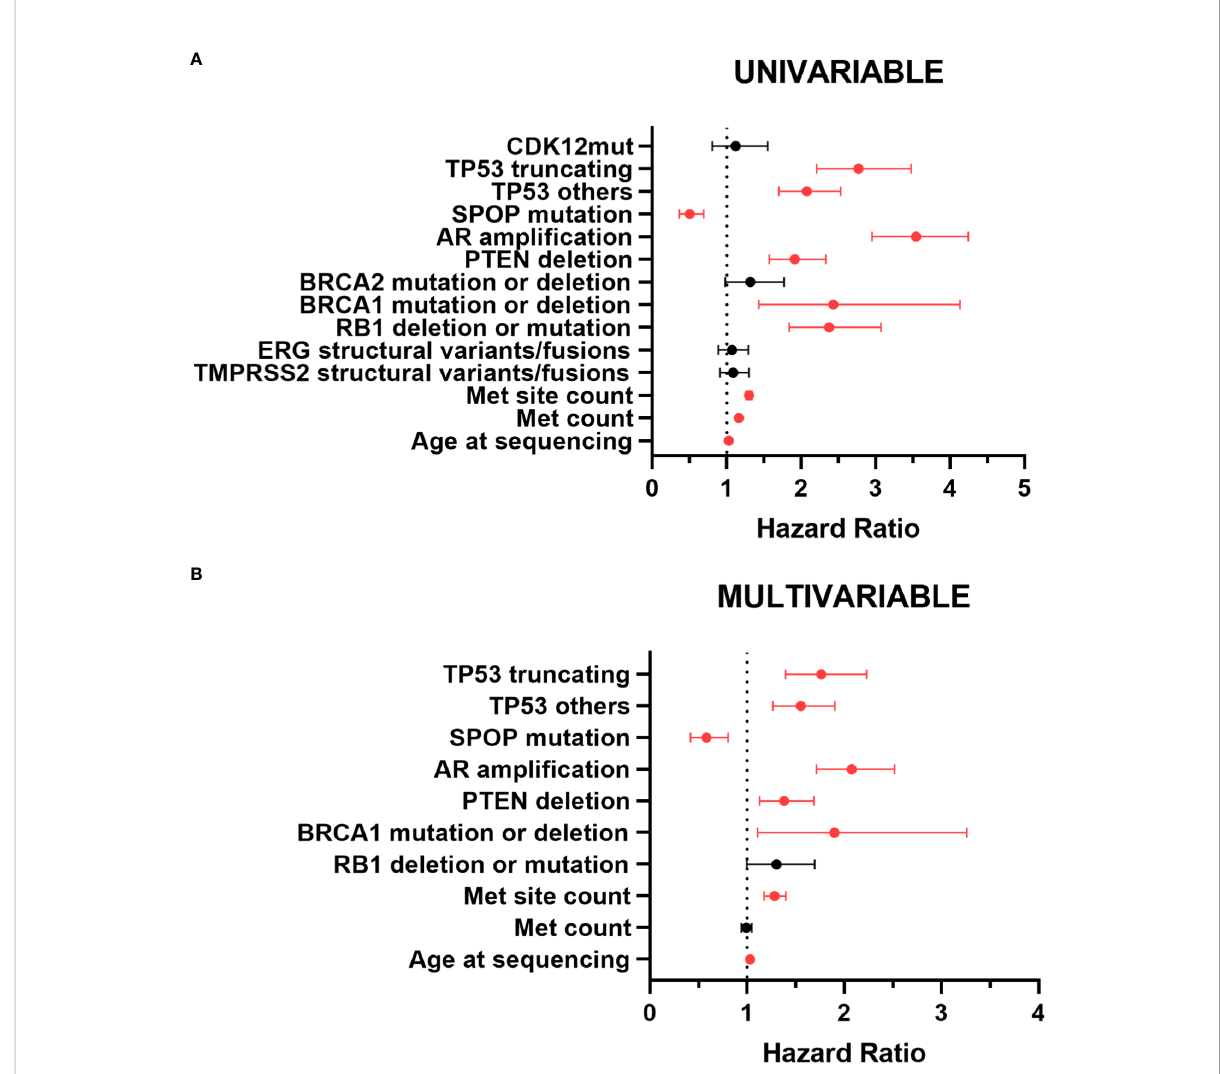
FIGURE 6 Forest plot for prognostic factors in patients with metastatic PCa by univariable (A) and multivariable (B) analyses. The forest plot reveals the HRs and 95% con fi dence intervals of the prognostic factors. Red color indicates signi fi cant p values. Met, metastatic; mut, mutation; HR, hazard